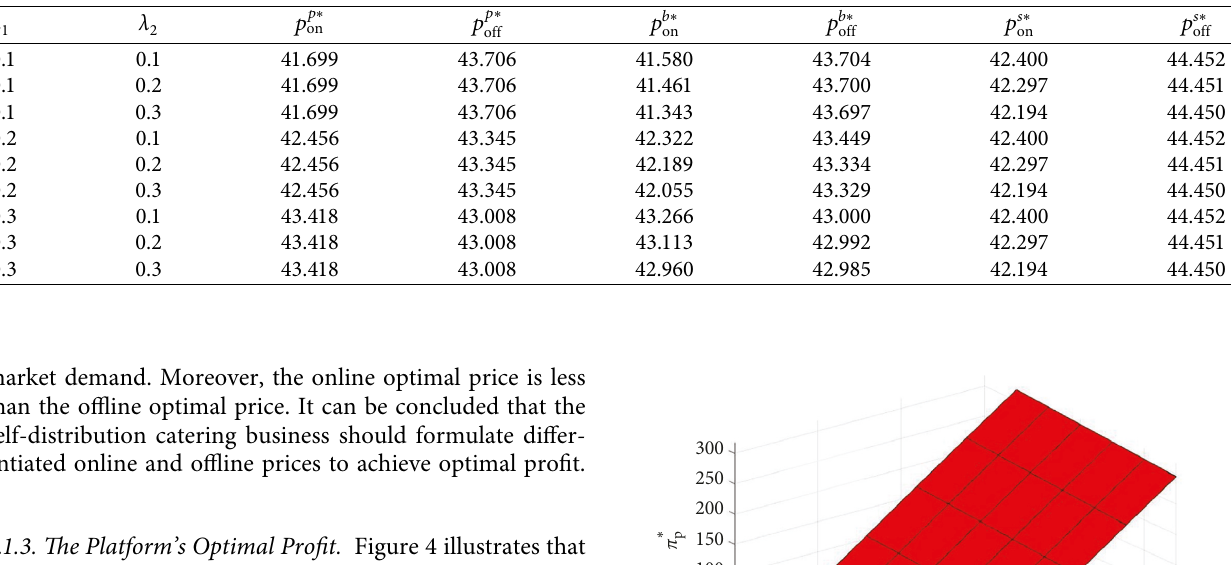
Table 4: Impact of change in λ 1 and λ 2 on dual-channel price.